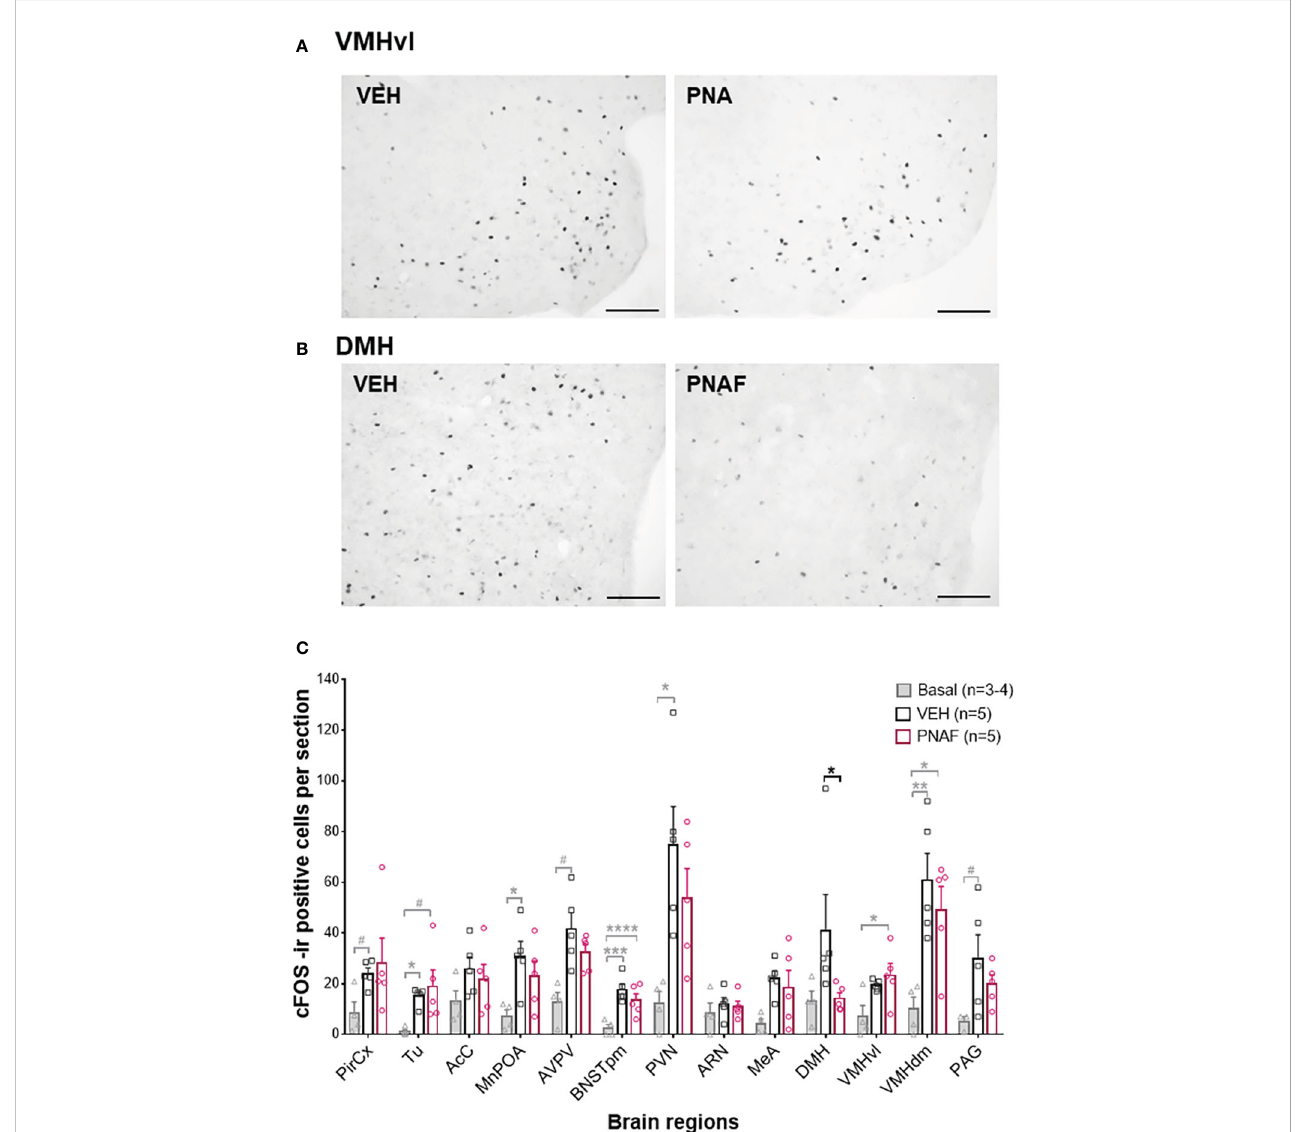
FIGURE 6 Prenatal DHT exposure decreases neural activation only in the dorsomedial hypothalamus of the PNAF modeling PCOS (A, B) Representative photomicrographs of cFOS immunoreactivity in the ventrolateral part of the ventromedial hypothalamus (VMHvl) (A) and the dorsomedial hypothalamus (DMH) in VEH and PNA mice. (C) Histograms representing the number of cFOS immunoreactive cells per section analyzed for each brain regions studied for Basal female who did not undergo lordosis behavior (grey bars), VEH control females (black bars) and PNAF (magenta bars) who were tested for lordosis behavior during the 6 th test. Mean +/- SEM. *p<0.05, Mann-Whitney test. VEH, controls; PNA, prenatally androgenized; Pir Cx, piriform cortex nuclei; Tu, olfactory tuberal nucleus; AcC, Accumbens nucleus core; MnPOA, median preoptic area; AVPV, anteroventral part of the periventricular nucleus of the third ventricle; BNSTpm, posterior median part of the bed nucleus of the stria terminalis; PVN, parventricular nucleus of the hypothalamus; ARN, arcuate nucleus; DMH, dorsomedial hypothalamus; VMHvl, ventrolateral part of the ventromedial hypothalamus; VMHdm, dorsomedian part of the ventromedial hypothalamus, MeA, medial amygdala; VTA, ventral tegmental area; PAG, periaqueductal nucleus. # p<0.07, * p<0.05, **p<0.01, ***p<0.001, ****p<0.0001. The grey bars and grey statistical signs represent the differences between the Basal and VEH groups while the black bars and black statistical signs represent the differences between the PNAF and VEH groups. VEH = control female; PNAF= prenatally androgenized female modeling PCOS. Mean +/- SEM. Scale bar: 100 m